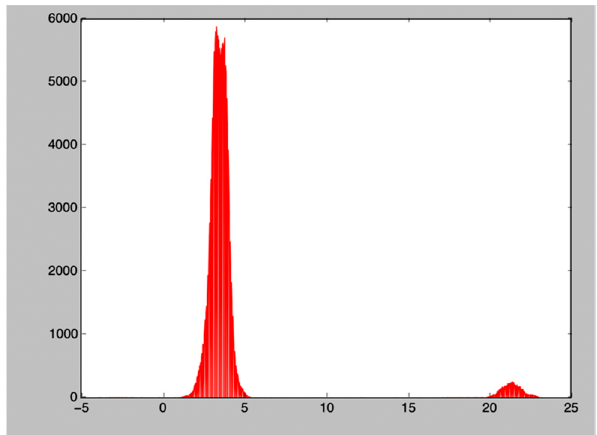
Figure 5. Histogram measurement of current data to determine current offset.